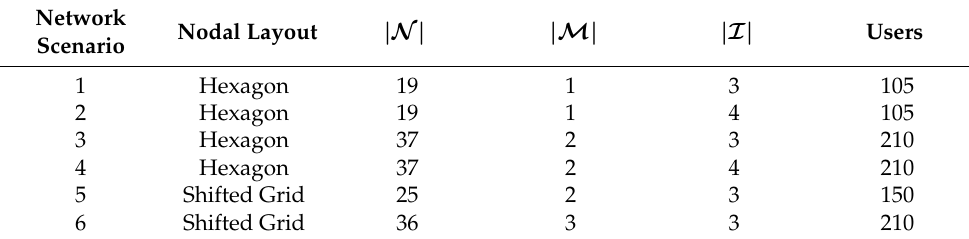
Table 4. Parametrization of the network